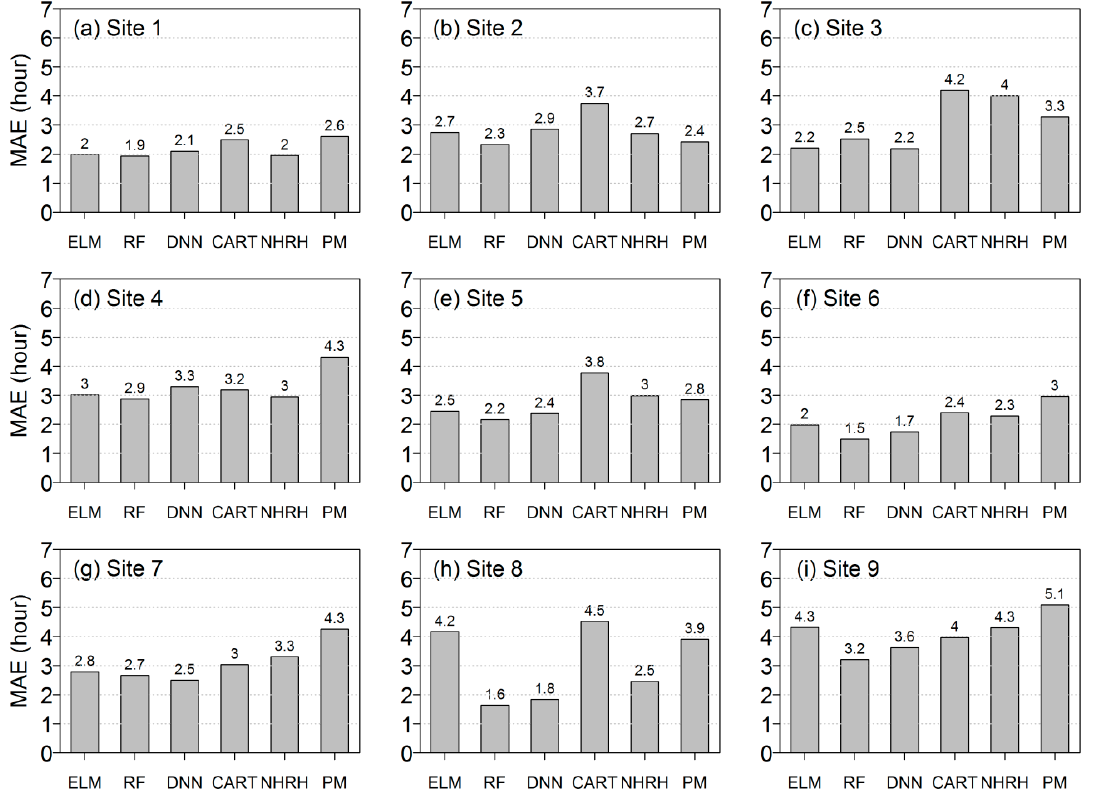
Figure 9. Mean absolute errors (MAEs) of the five LWD prediction models for all employed stations. Note that the used data sets are the same as those used in Table 3.